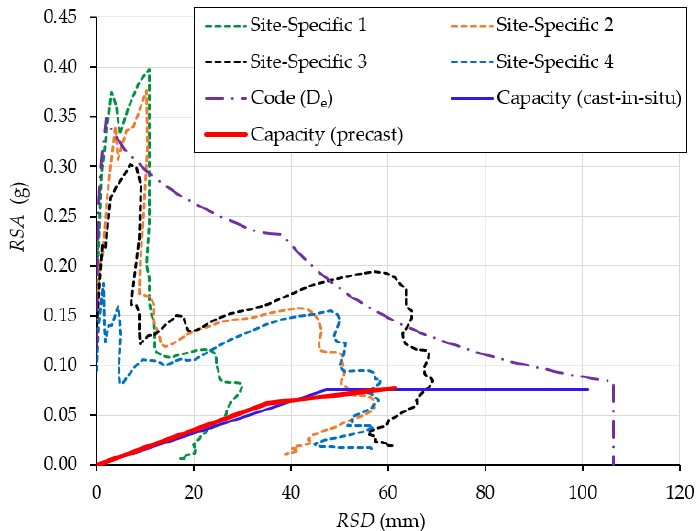
Figure 14. Capacity and demand curves of the case study building. The code demand curve was derived assuming a 2500-year return period ( 𝐾 𝑝 𝑍 = 0.144 g ) on site class D e . derived assuming a 2500-year return period ( K p Z = 0.144 g) on site class D e